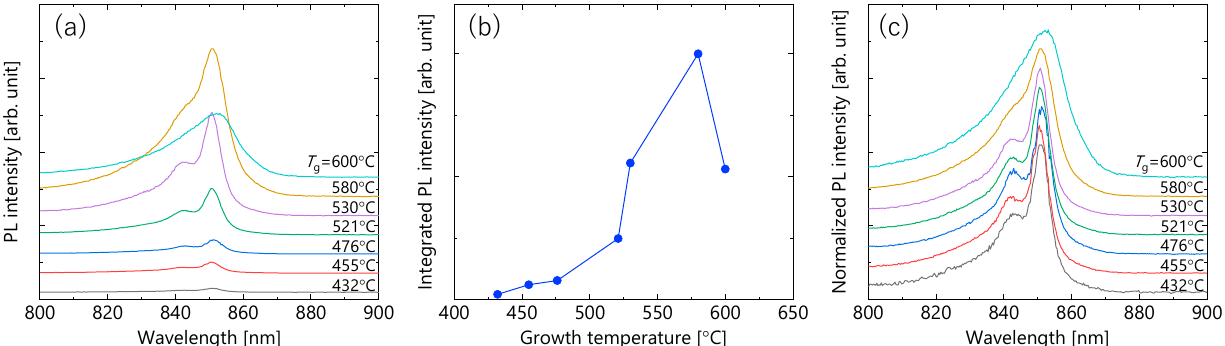
Figure 4. X-ray diffraction (XRD) profiles of θ -2 θ scan at the (220) diffraction for the samples with given T g . The x-axis is the angle relative to the diffraction angle of GaAs. The satellite peaks derived from the periodic structure of multiple quantum wells (MQWs) are indicated by the arrows.